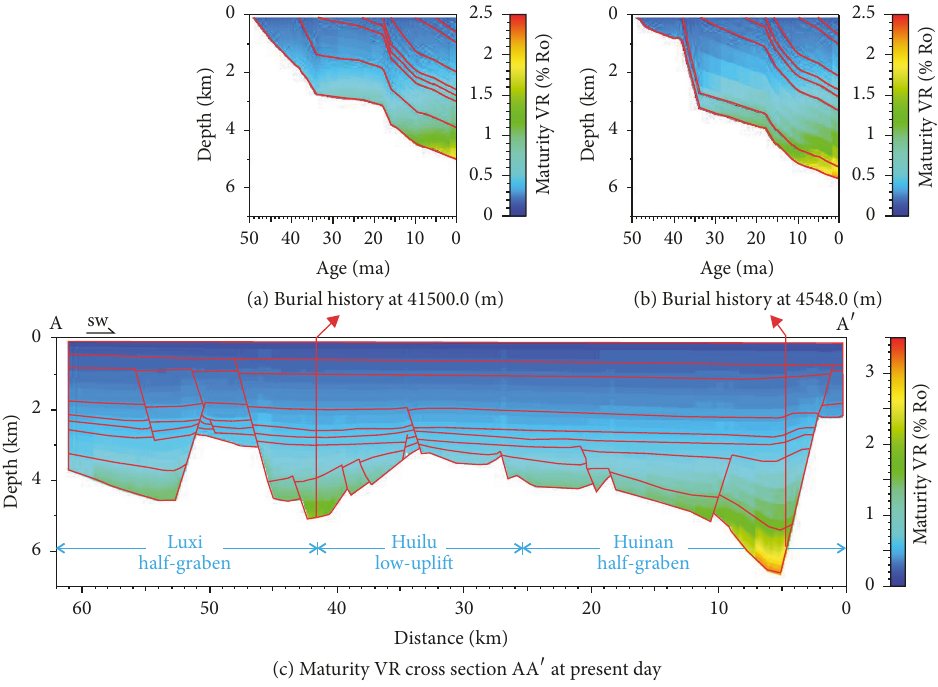
Figure 19: Modeled thermal maturity expressed as vitrinite reflectance (% Ro) in the Huilu low-uplift area (the locations of the profile AA 󸀠